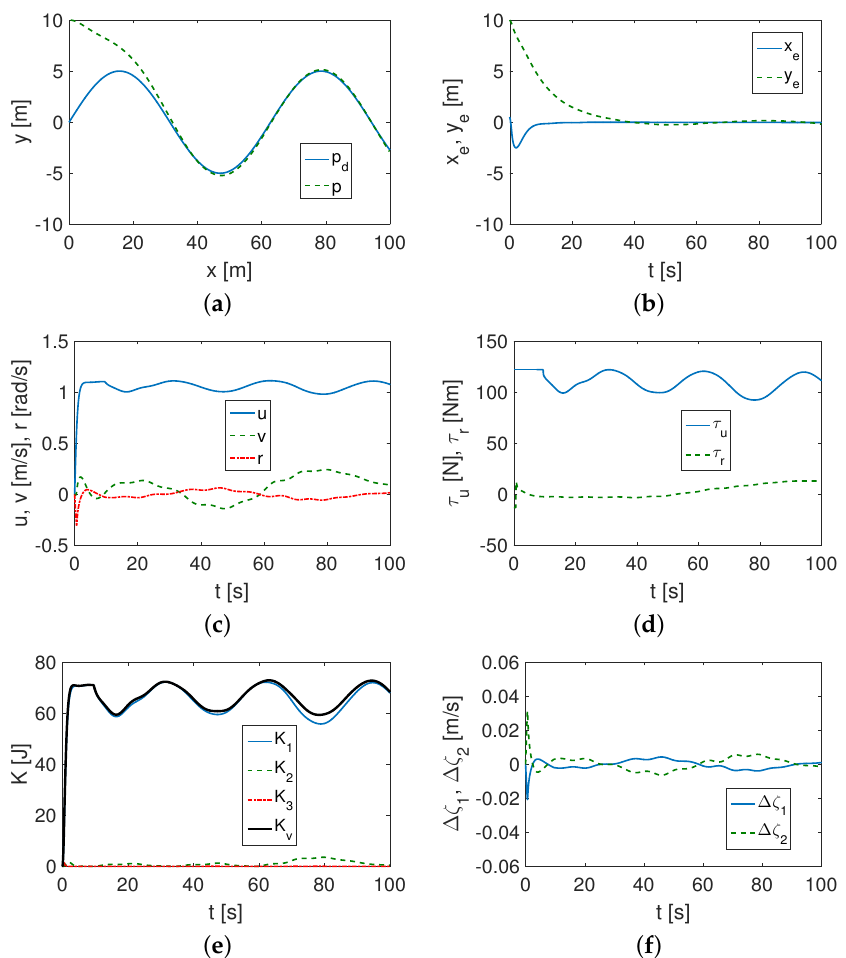
Figure 6. Results for the CETUS II, QV controller and sine trajectory: ( a ) desired and realized trajectory; ( b ) position errors; ( c ) velocity errors; ( d ) applied force and torque; ( e ) kinetic energy time history; ( f ) quasi-velocity errors ∆ ζ 1 , ∆ ζ 2